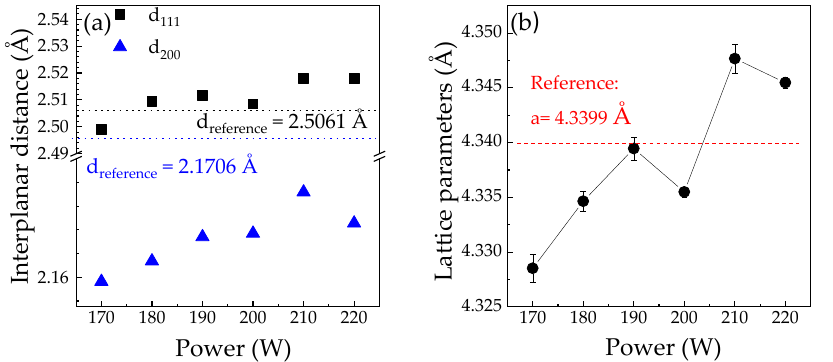
Figure 2. ( a ) Interplanar distances obtained from the Bragg law, and calculated from (111) (circles) and (200) (triangles) reflections and ( b ) Lattice parameter obtained from XRD.